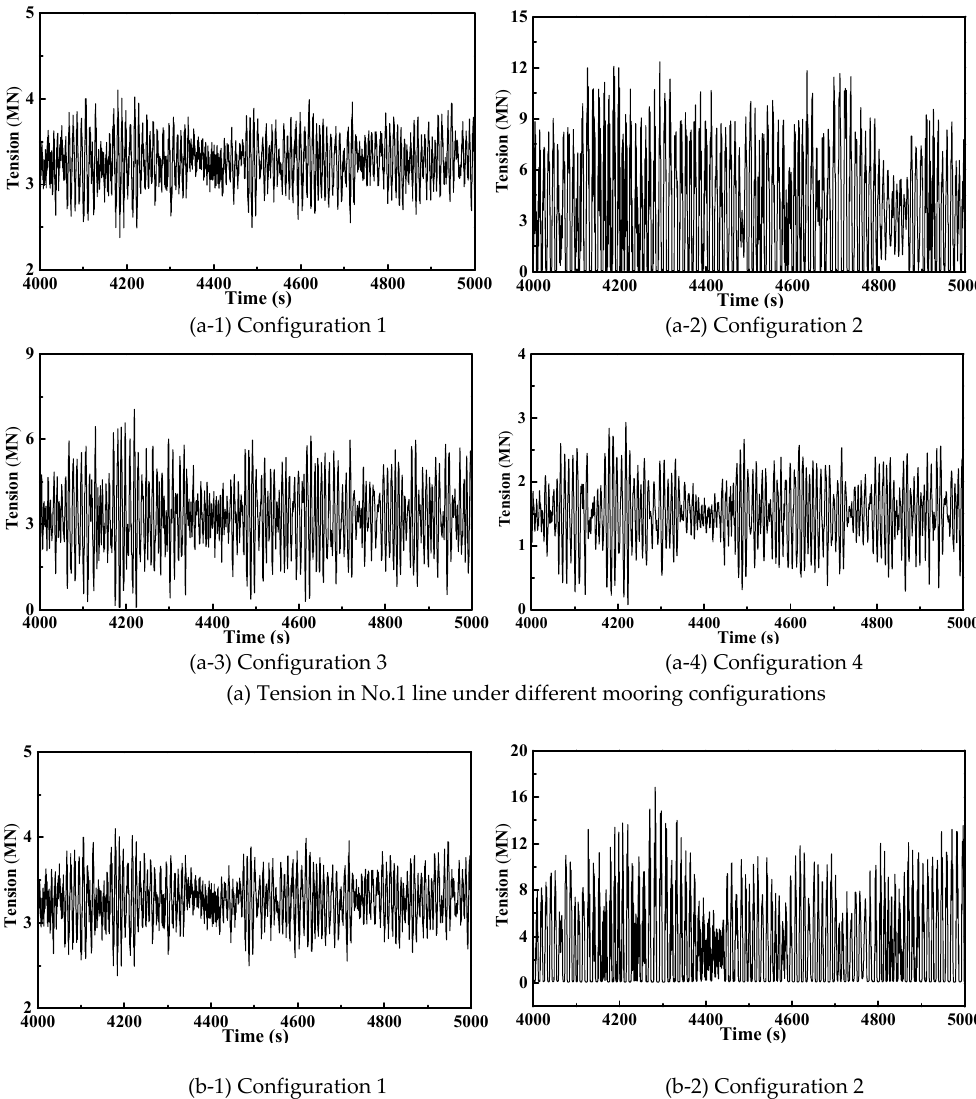
Figure 6. Statistics of the bending moment at the root of blade and tower base under different mooring configurations.